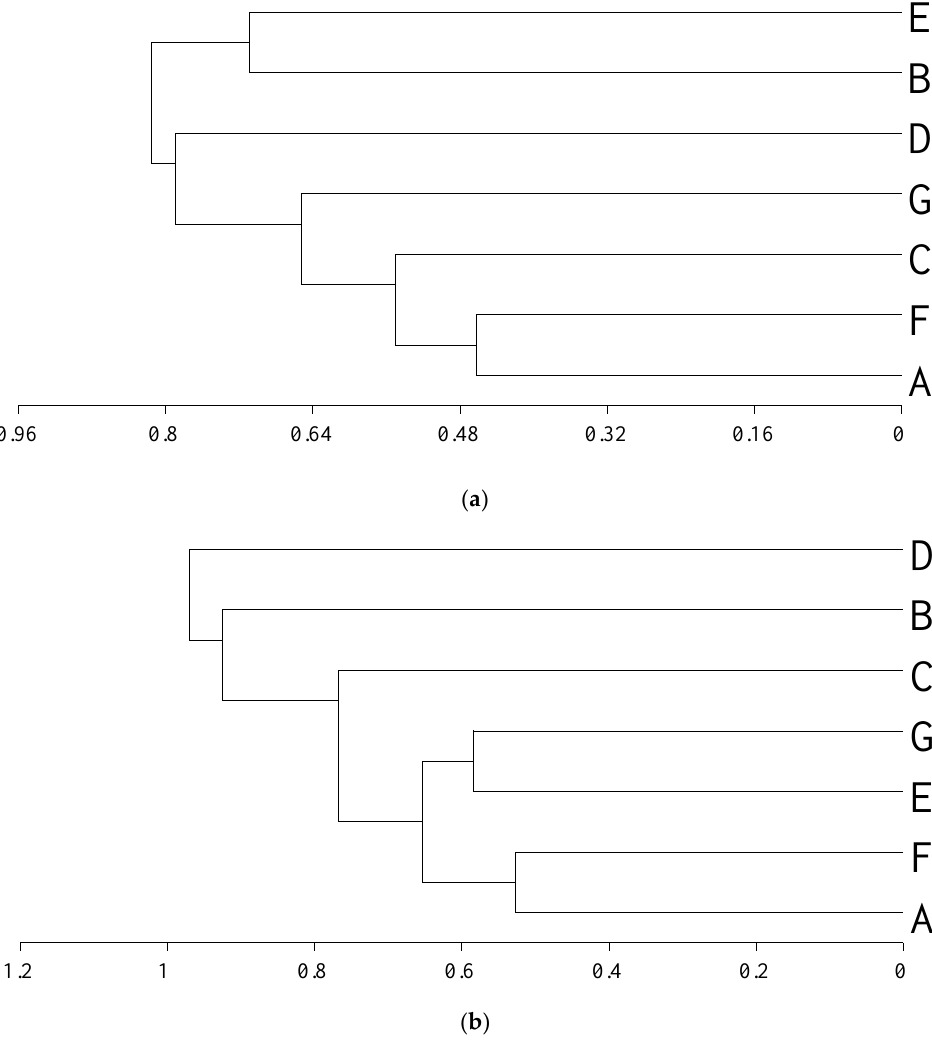
Figure 6. Bray – Curtis dissimilarity of Oribatida ( a ) and Mesostigmata ( b ) in microhabitats of broadleaf forest in Eastern Norway: A — moss on ground, B — lichens on tree twigs lying on ground, C — moss on tree trunks at ground level, D — moss on tree trunks 1.5 m above ground, E — moss on decaying stump, F — moss on decaying log, G — decaying wood from trees.